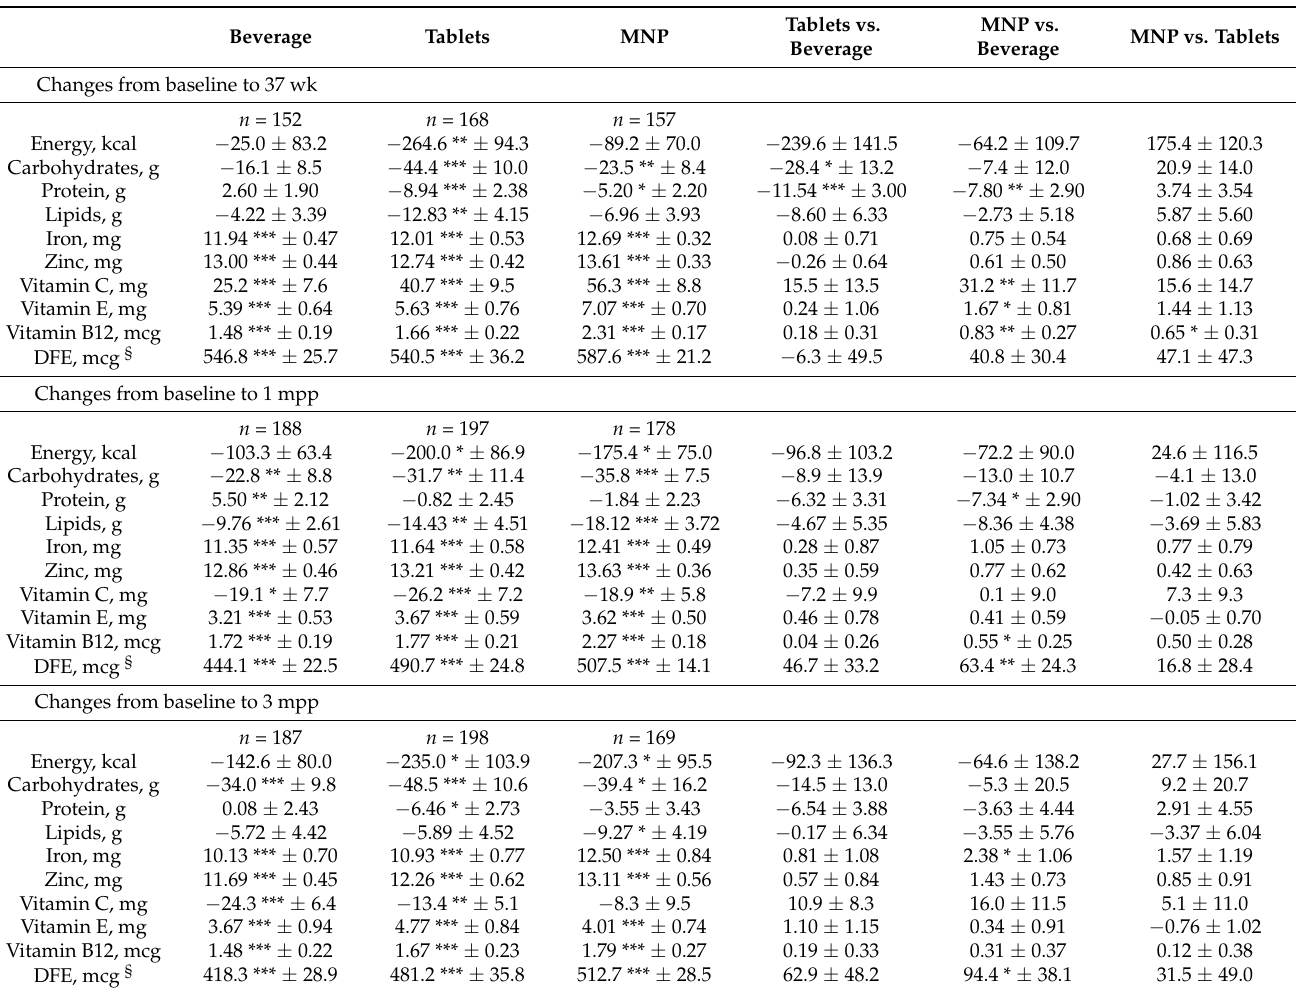
Table 4. Covariate-adjusted median changes † of nutrient intake from diet plus supplements, by evaluation study groups ‡ and period Φ